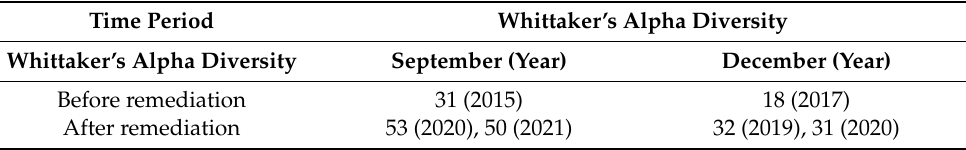
Table 1. Comparison of Whittaker’s alpha diversity calculated before and after remediation; note that there are two post-remediation years for each